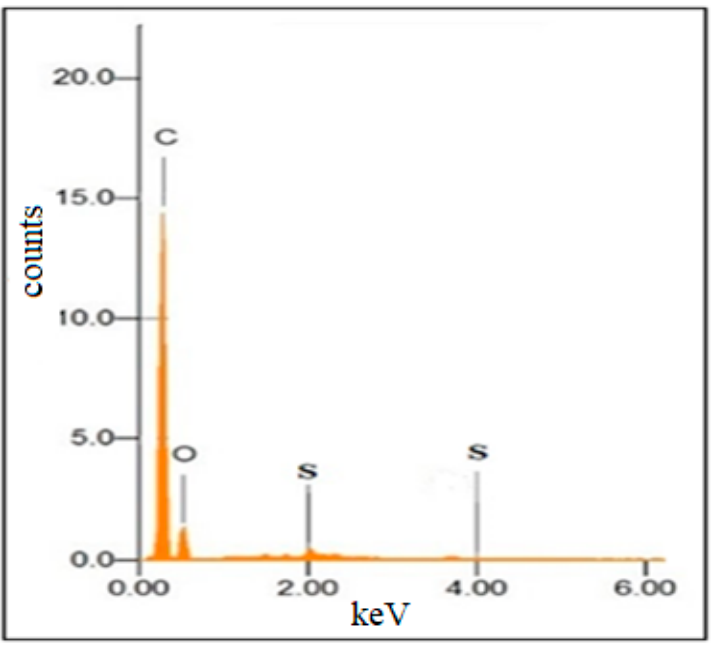
Figure 3. Elemental analysis of tea waste catalyst.